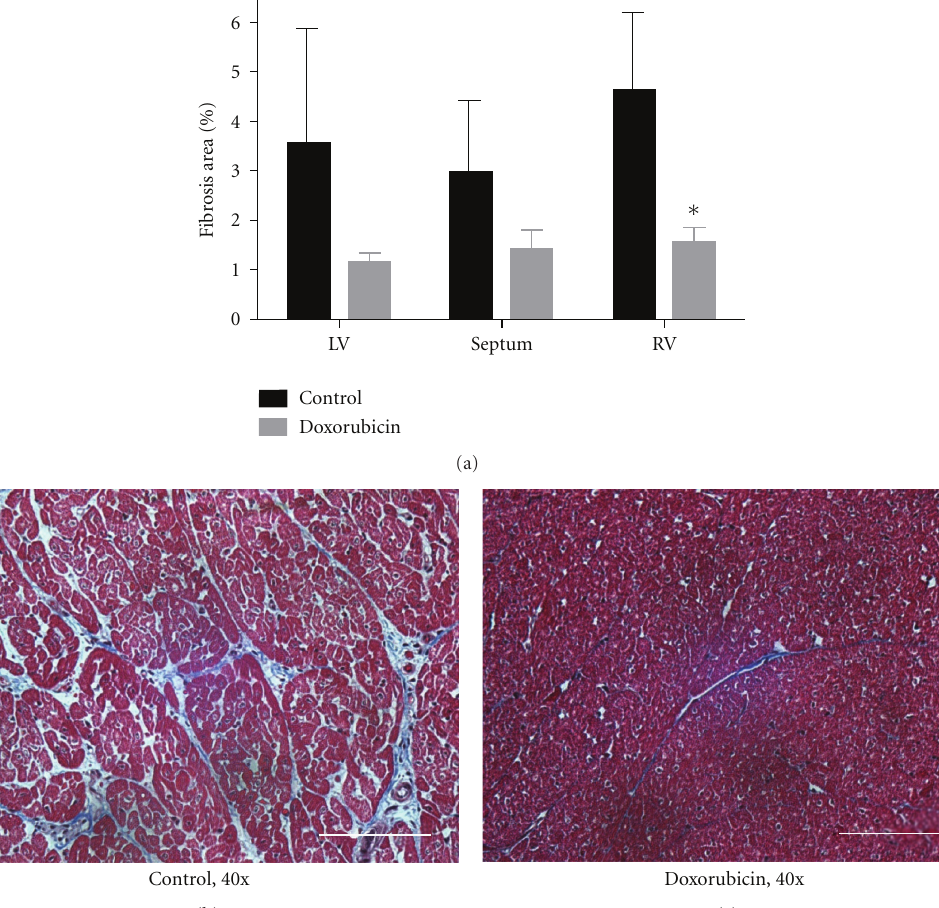
Figure 3: (a) Interstitial fibrosis as determined by Masson’s Trichrome staining in control and doxorubicin-treated hearts. (b) and (c) Representative histomicrographs of myocardial architecture in control and doxorubicin-treated hearts. In control animals, the outlines of individual myocytes are apparent. Interstitial endo- and perimysium are well established and clearly visible. In doxorubicin treated animals, normal myocyte borders are not apparent, and connective tissue is largely absent. 40x, white bar = 50 μ m, ∗ P < 0 . 05 versus control. LV, left ventricle; RV, right ventricle; n =